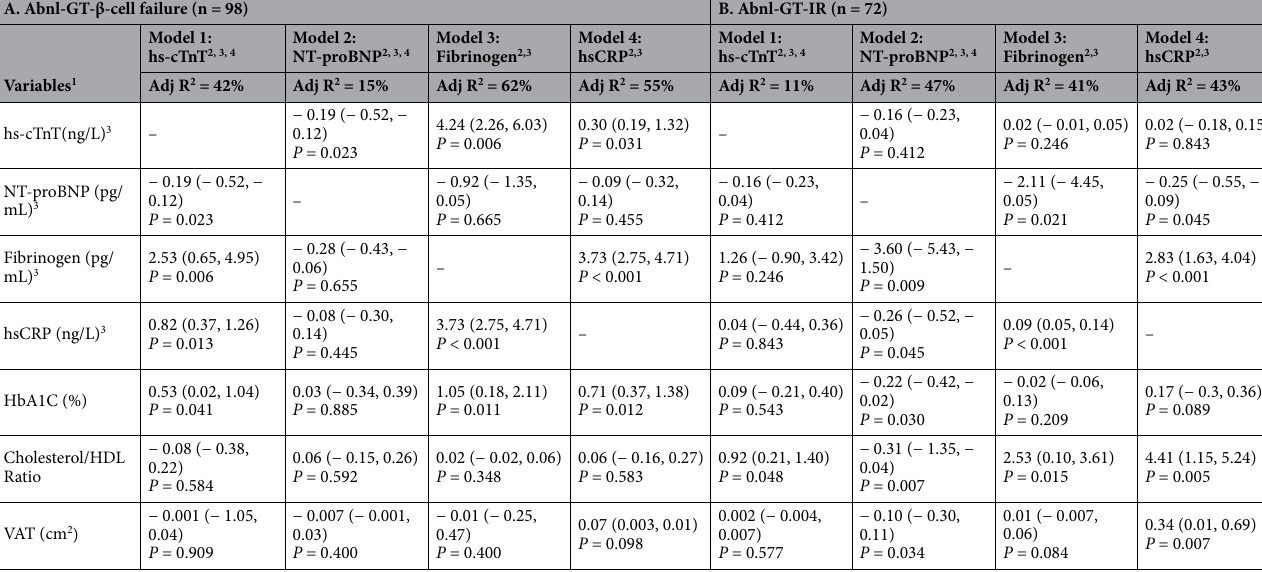
Table 2. Associations between cardiovascular biomarkers, inflammatory markers, HbA1C, cholesterol/HDL ratio and VAT in each Abnl-GT Group by multiple regression. 1 Data provided is β-coefficient and 95% CI. 2 Natural logarithmic transformed values of hs-cTnT, NT-proBNP, fibrinogen and hsCRP were used. 3 Models adjusted a priori for: age, sex, hypertension status and smoking. 4 Model adjusted for African region of origin and